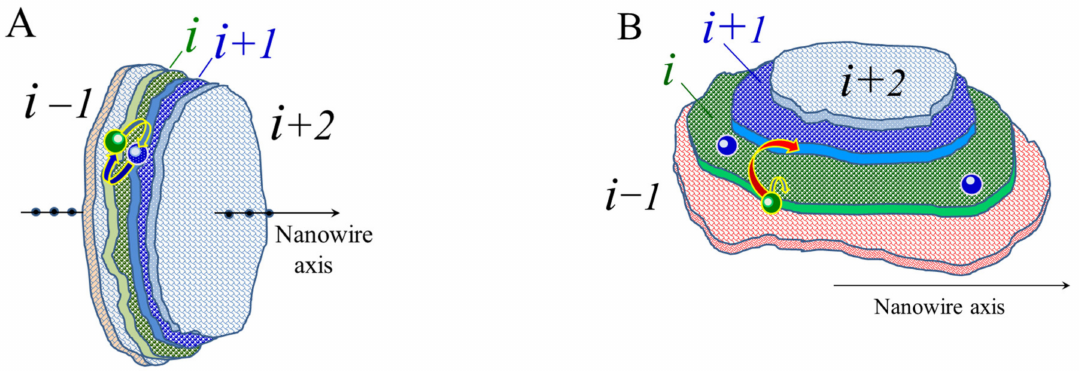
Figure 3. Scheme of a fragment of a modulated nanowire ( A ) and a hillock ( B ) for estimating the calculation of the balance of surface fluxes of atoms from layer i to layer ( i + 1 ) and back. In subsection ( B ), long jumps marked in red are